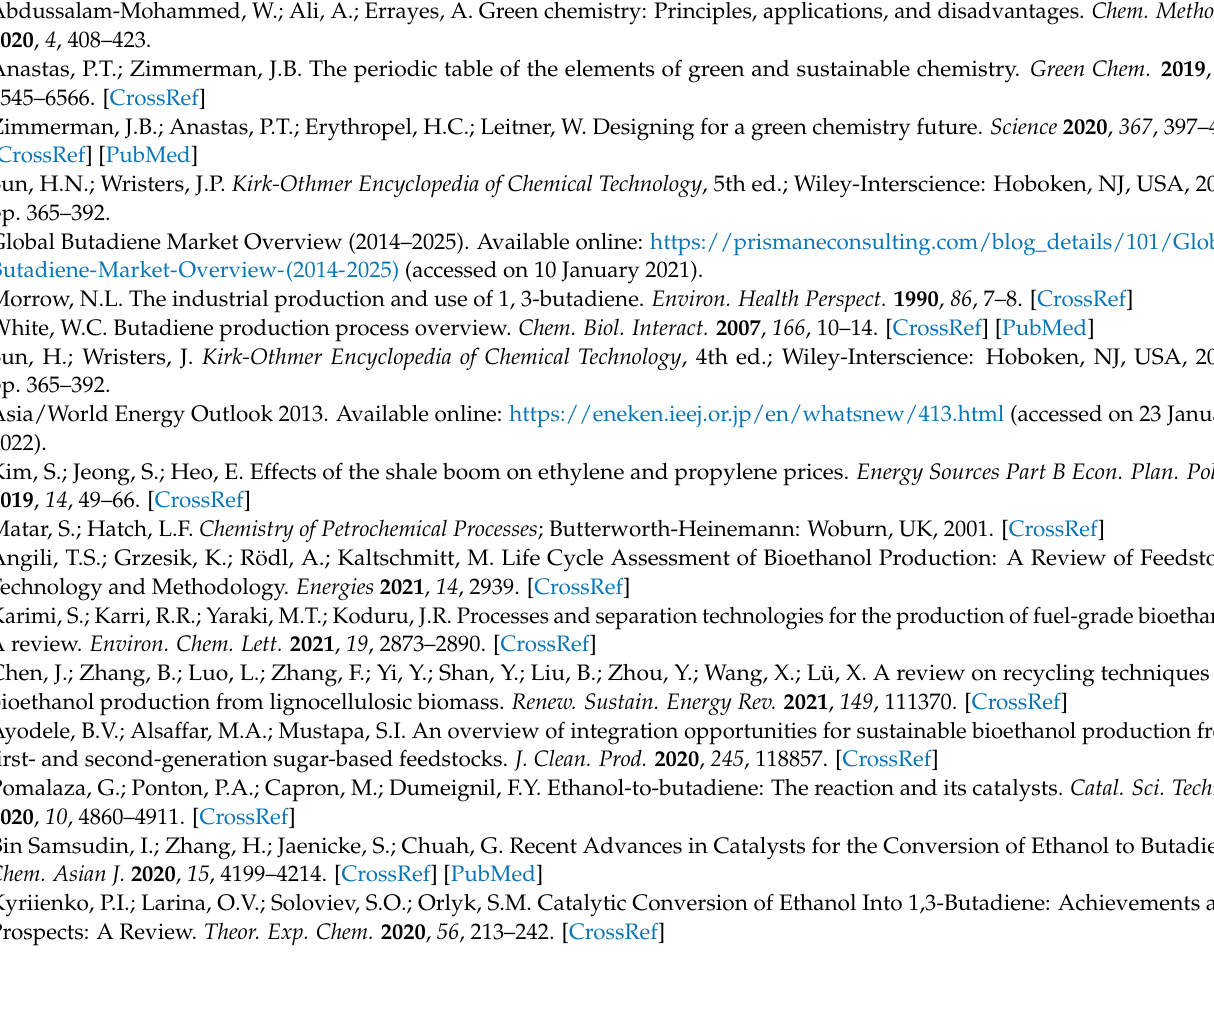
Figure S7: Ethanol conversion, BD selectivity and yield for MgO-SiO 2 -4 (AE) as a function of (a) GHSV and (b) contact time; Figure S8: SEM images for MgO-SiO 2 -4 (AE) after reaction; Figure S9: Ethanol conversion and butadiene selectivity over MgO-SiO 2 -4. Cycle 1: fresh catalyst, cycles 2 and 3: regenerated catalyst; Table S1: Density of acidic and basic sites from NH 3 and CO 2 TPD; Table